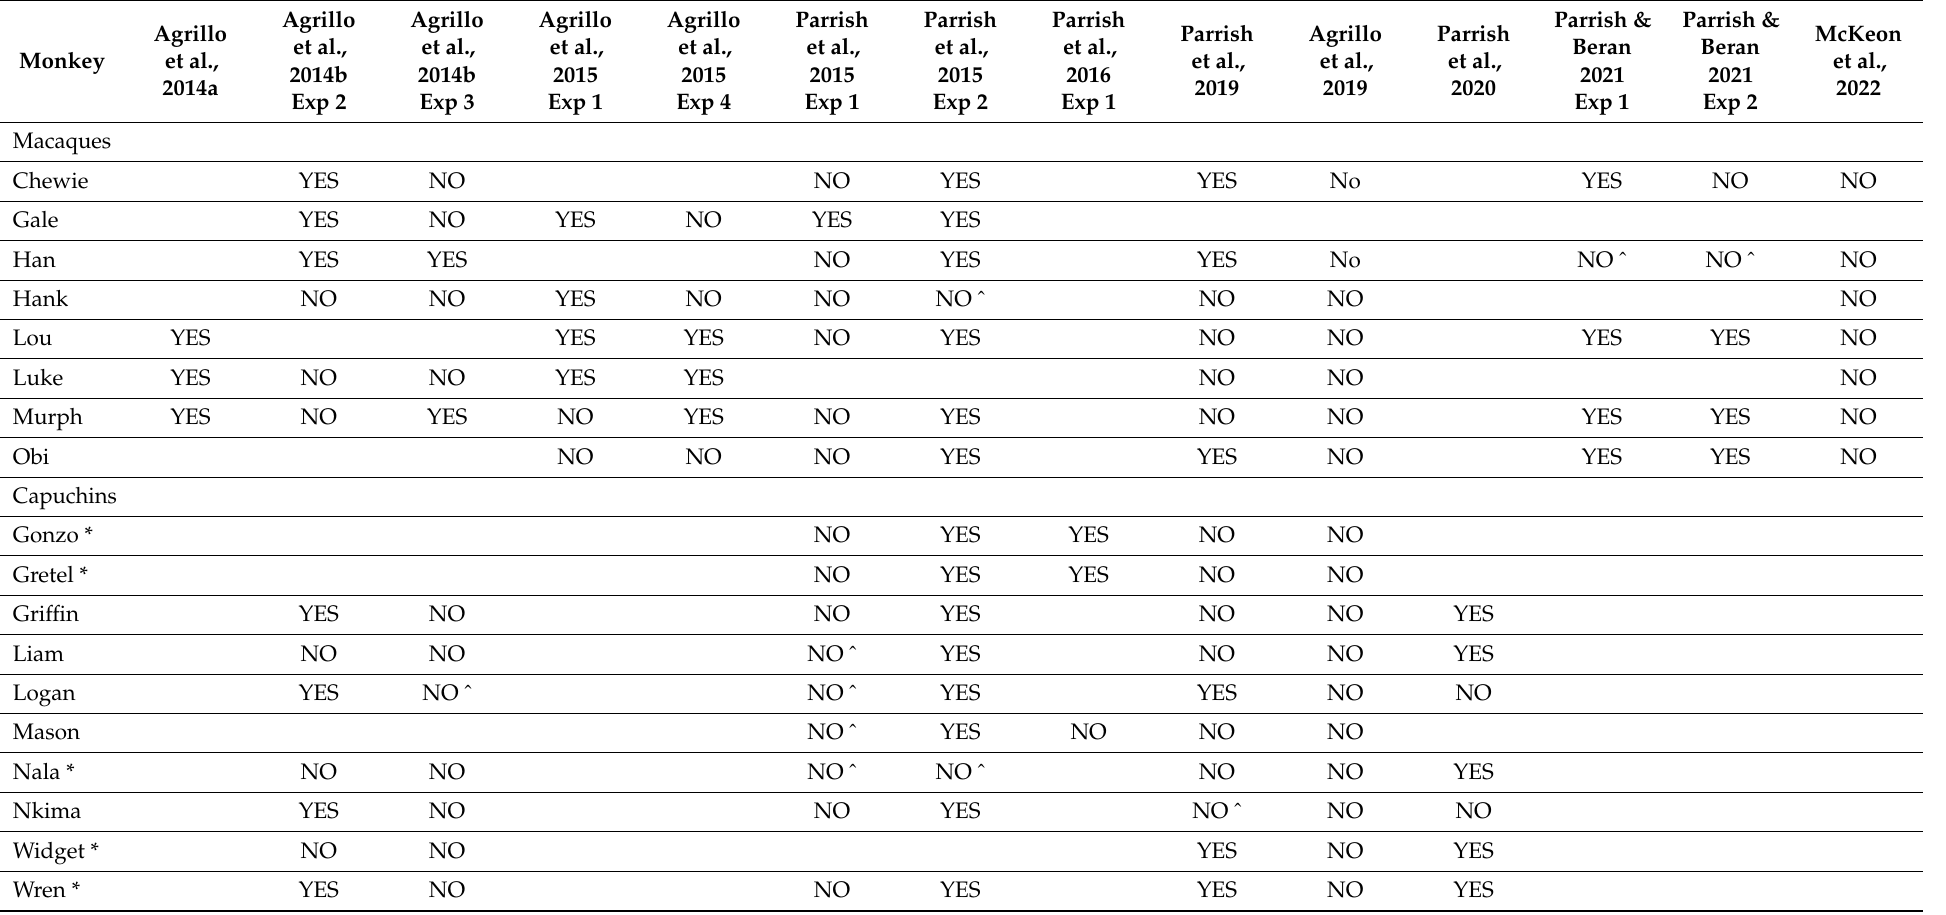
Table 1. Susceptibility of each monkey in each experiment in terms of experiencing the illusion in the same direction as for humans.